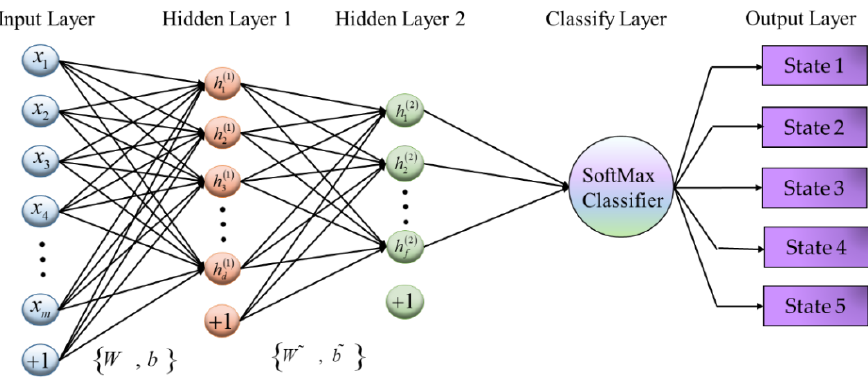
Figure 2. The structure of the two hidden layer sparse autoencoder with a SoftMax classifier.